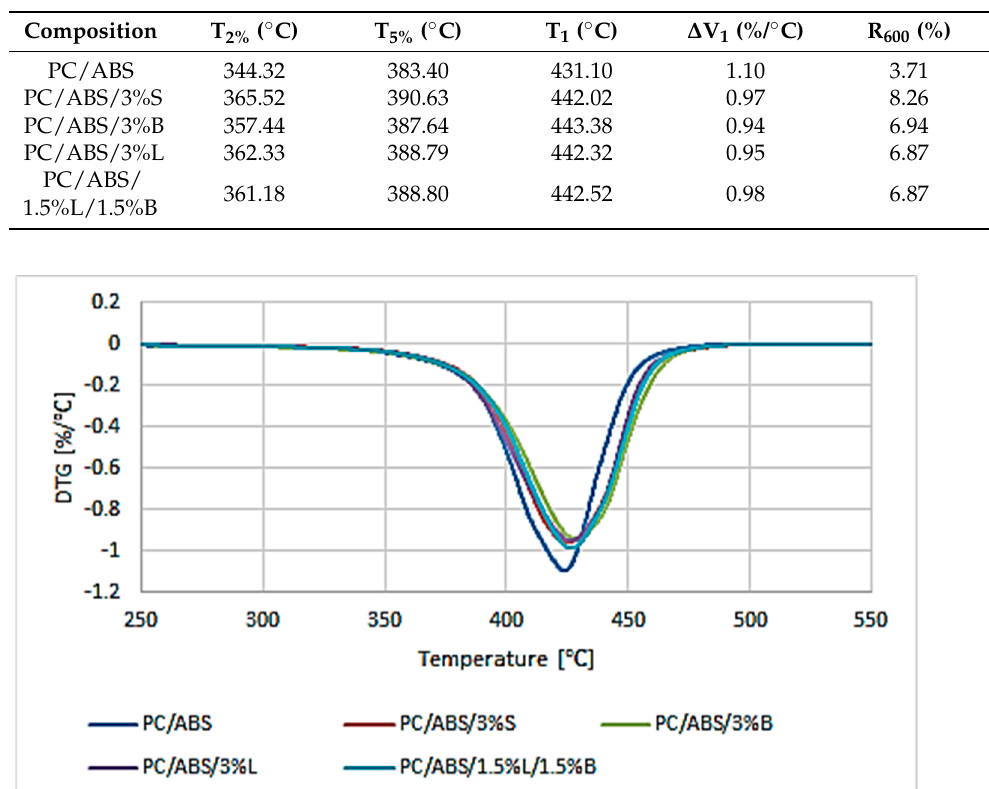
Table 4. The results of research on the properties of the thermostability of composites.